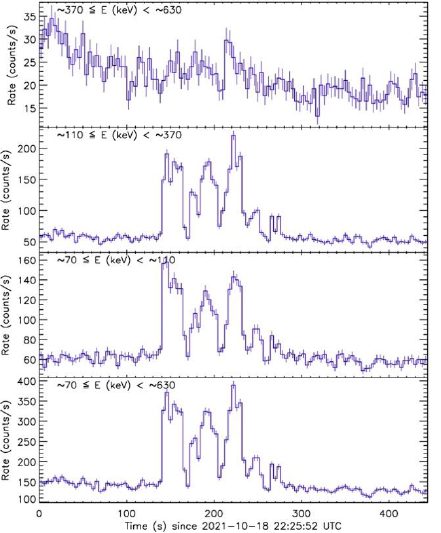
Figure 2. Light curves of GRB 211018A observed by GRBAlpha in different energy bands [30].